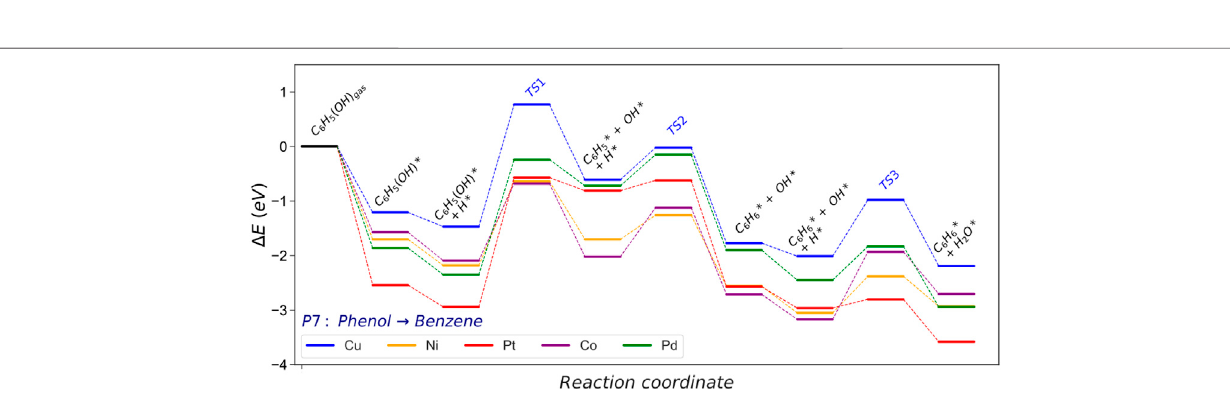
FIGURE5 | Energy pro fi le ofthe demethylation (DME) and demethoxylation (DMO)pathwaysconvertinganisole into phenol and benzene on Fe (110). Theasterisk (*) represents adsorbed surface species. Molecular functional groups are denoted in parenthesis.